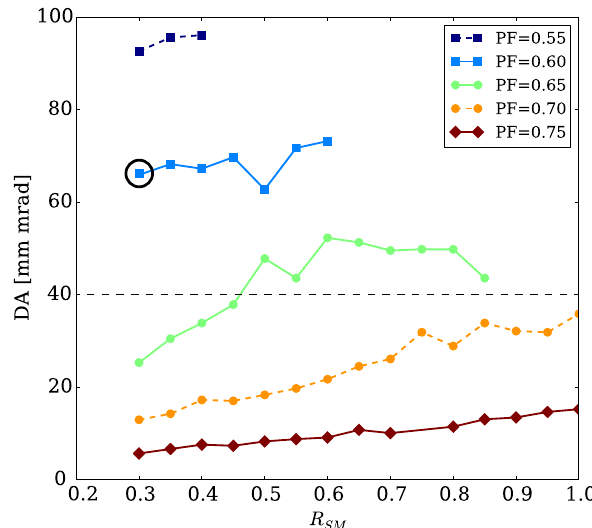
FIG. 3. The DA is shown for the stable lattices in Fig. 2 which have the required target tune at Q h ¼ 7 . 7 , Q v ¼ 2 . 7 . As R SM decreases and the packing factor (PF in the figure key) increases, the lattice circumference reduces. The smallest circumference lattice with a DA above our threshold of 40 mm mrad, this lattice is indicated by a black